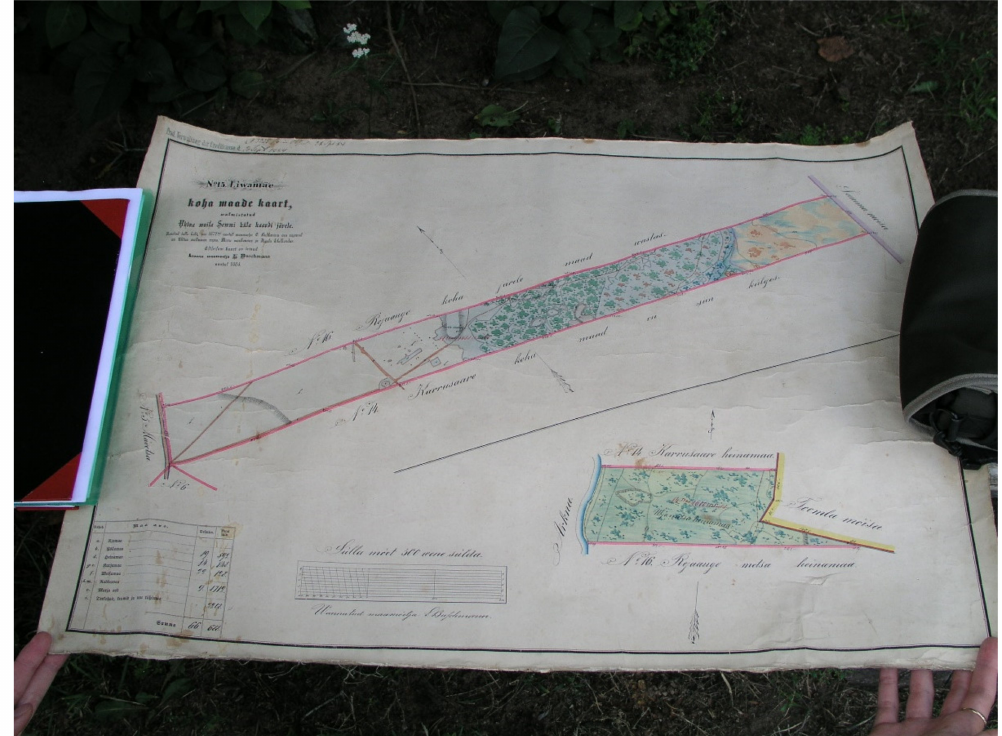
Figure 1. A keepsake: hand-coloured map of a farm from 1872/1884 presented during fieldwork. Sämi-Tagaküla village, Rakvere municipality, Lääne-Viru county (photo: Anu Printsmann